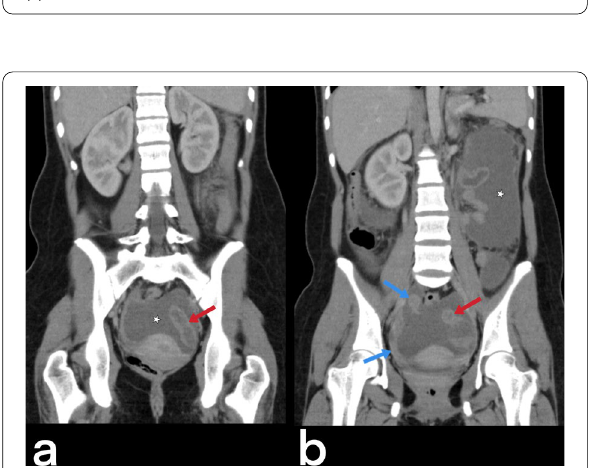
Fig. 41 Bilateral tubo-ovarian TB in a 15-year-old-female with pelvic pain. Axial pre-contrast T1 weighted ( a ), post-contrast T1 weighted ( b ), and T2 weighted ( c ) MR images show bilaterally enlarged ovary (stars) and dilated fallopian tubes (arrowheads). On T2-weighted MR image obtained after antituberculous therapy of 10 months, bilateral ovaries (arrows) and fallopian tubes (not shown) appear normal ( d )